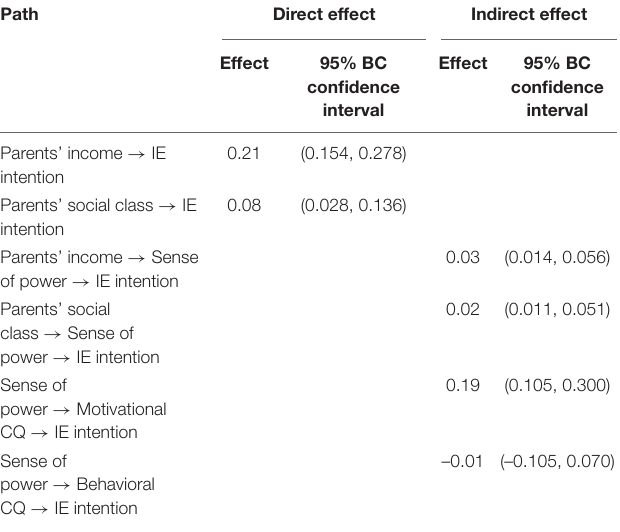
TABLE 3 | Indirect path